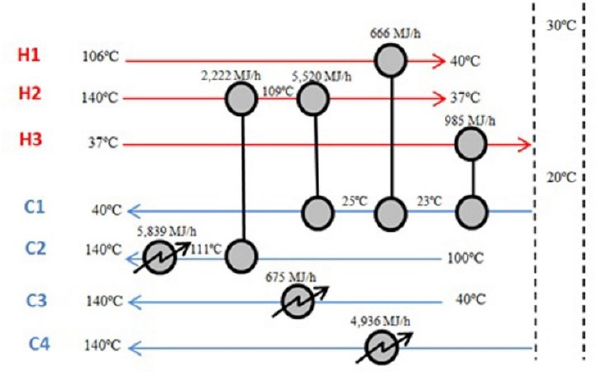
Fig. 2. Exchange network obtained from the pinch method Table 3. Process equipment with and without HEN